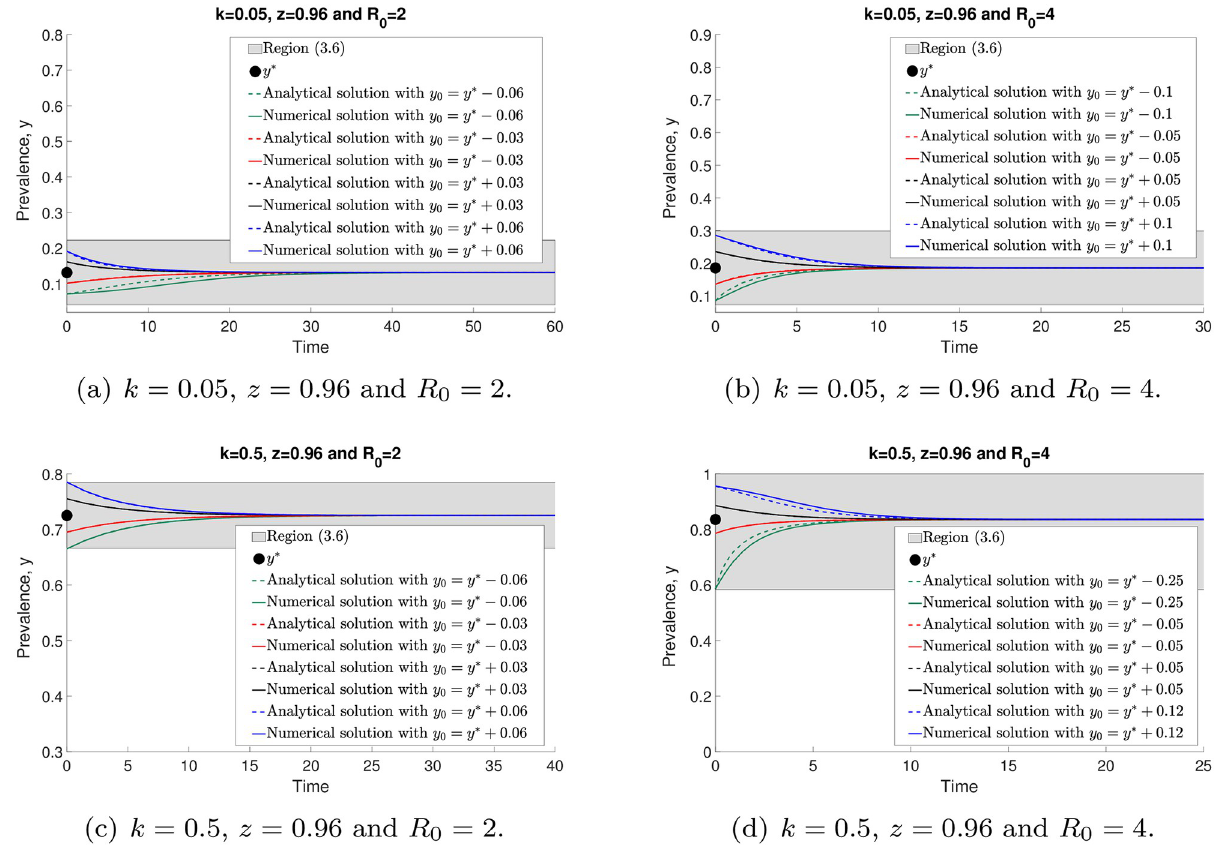
Fig 8. The comparisons of analytical (12) and numerical (5) solutions with arbitrary initial points around the stable endemic equilibrium, y � .